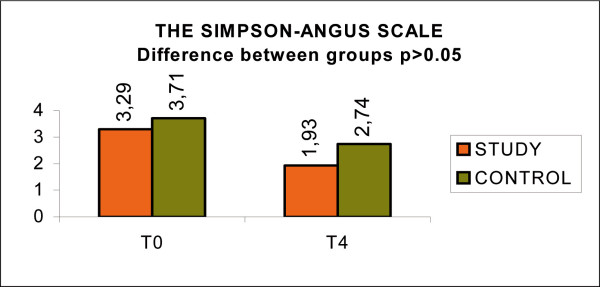
Simpson-Angus scale.